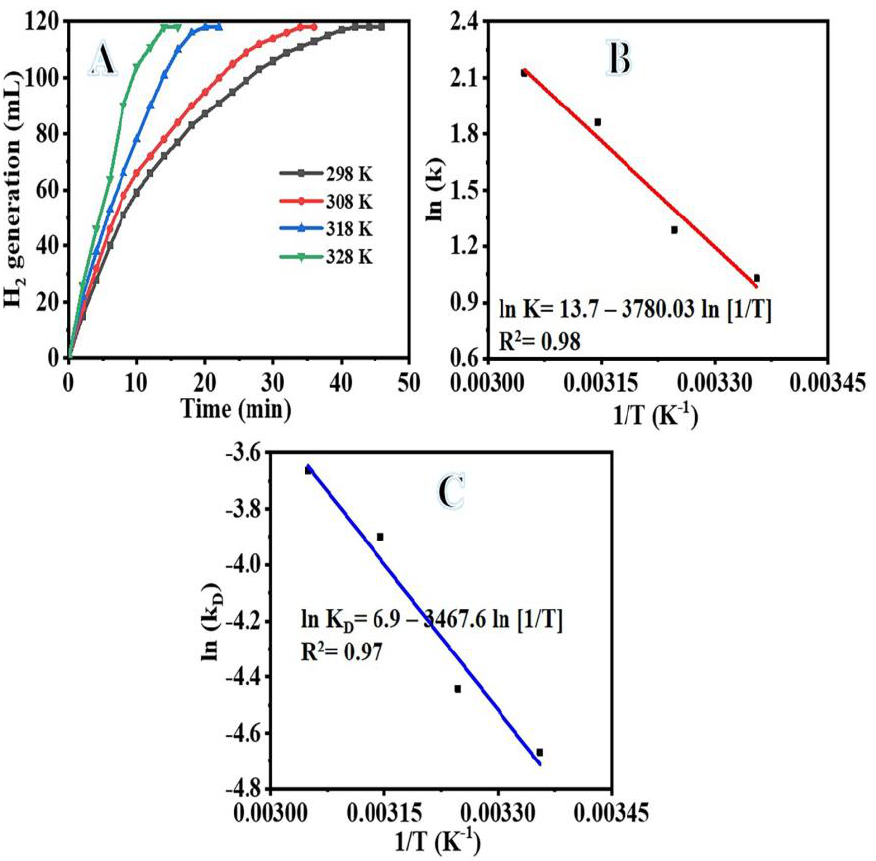
Figure 9. The impact of temperature on the reaction ( A ), ln (k, rate constant) vs. temperature inverse ( B ), and ln KD (K/T) vs. temperature inverse ( C ). The amount of Ni 75 Pd 25 @PVDF-HFP NFs membrane catalyst = 100 mg and [SBH] = 1 mmol. Table 3. E a of prepared NFs, and catalysts based on Pd and Ni used in H 2 generation using NaBH 4 .